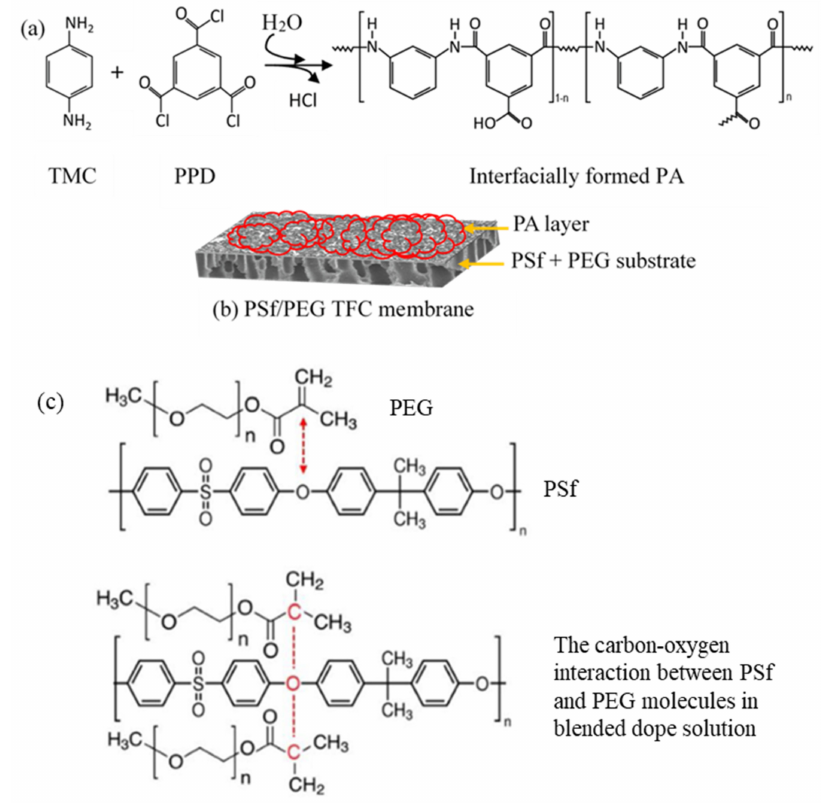
Figure 4. ( a ) Crosslinking reaction of the PA layer on the TFN membrane; ( b ) modified TFC membrane; and ( c ) synthesis pathway for the modified membrane substrate with PEG